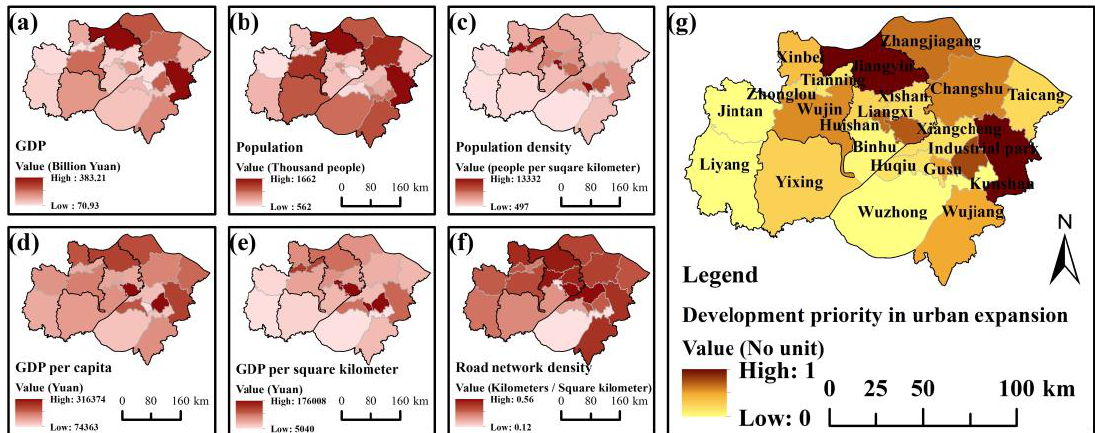
Figure 7. Assessment results of development priority of 23 districts in our study area. The priority was quantized by the normalization of six indicators including GDP ( a ), population ( b ), population density ( c ), GDP per capita ( d ), GDP per square kilometer ( e ), and road network density ( f ) in 2018, which were commonly used as criteria of land quota for urban expansion in the Chinese context. ( g ) shows the comprehensive development priority of the 23 districts calculated by the six indicators with equal weight.